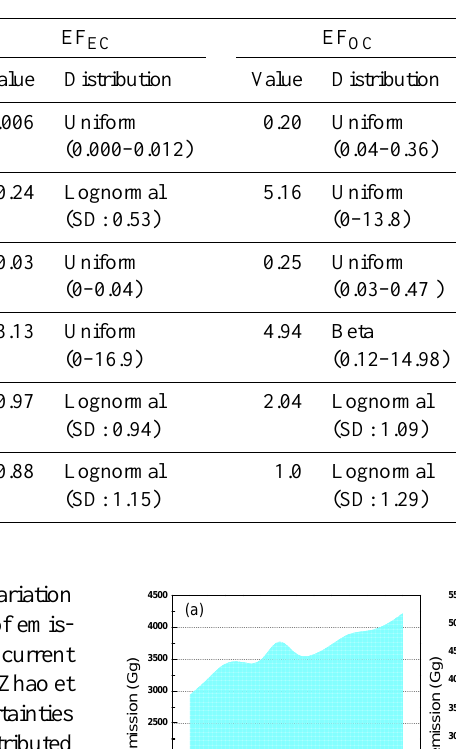
Table 1. EC and OC emission factors for coal and biofuel burned in small stoves (gkg − 1 ). The values in parentheses indicate the range (for uniform distribution), 95% CI (for beta distribution), or standard deviation (SD; for lognormal distribution) of the emission factor.